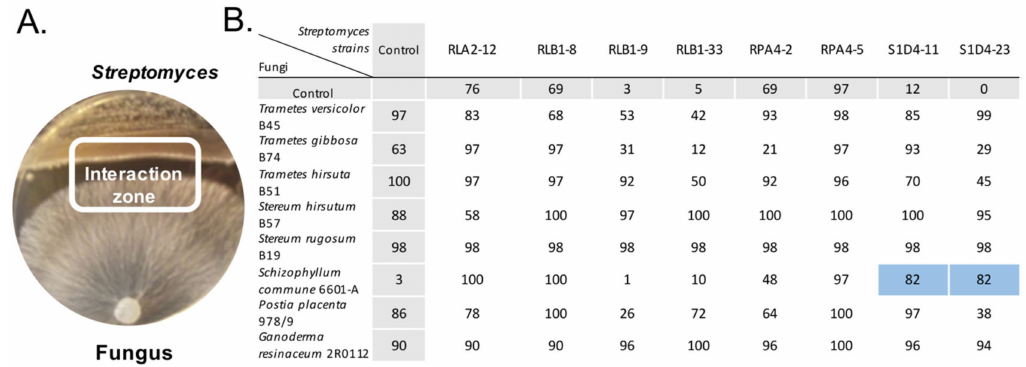
Figure 1. Streptomyces -fungus co-culture setup and screening. ( A ) Illustration of a Streptomyces -fungus co-culture after 14 days of growth. ( B ) Screening of bioactive molecules elicited during the co-culture. The compound extracts of mono- cultures of fungi and Streptomyces (rows and columns named “control”) in GA medium were compared with the extracts resulting from their co-culture in a bioassay experiment against the growth of B. subtilis ATCC6633. The values in the table indicate the percentage of inhibition of B. subtilis ATCC6633 after a 24 h growth period in comparison with a control grown in absence of the extract. The two co-cultures between S. commune 6601-A with S1D4-11 and S1D4-23 (highlighted in blue) were selected as they presented a significant ( t -test p value < 0.05) impact on the growth of B. subtilis ATCC6633 in comparison with the